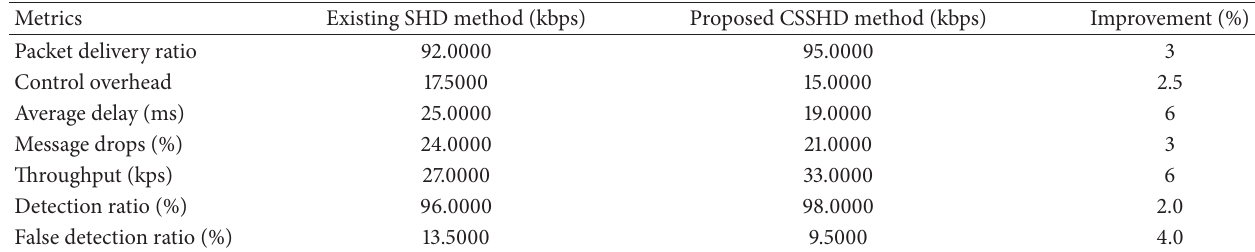
Table 5: Comparison result.